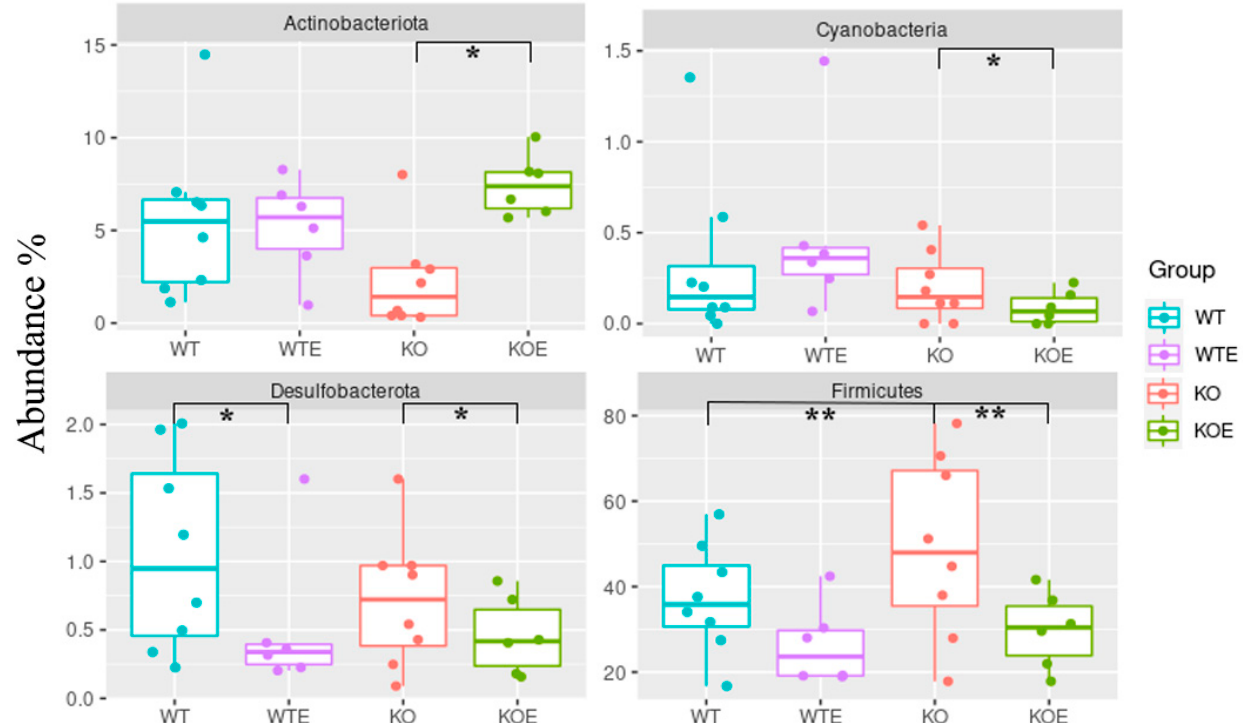
Figure 5. Influence of alcohol and genotype on mice in the four dominant phyla. The abundances of each phylum were assessed for significant differences in WTE vs. WT, KOE vs. KO, and KO vs. WT. A differential expression analysis was determined using the DESeq2 package and is shown in Table 1. Library normalization was performed using the poscounts method and local fitting for the negative binomial distribution model. The Benjamini–Hochberg method was applied to perform p -value correction. * p < 0.05, ** p < 0.01. Table 1. Differential expression in the bacteria phylum in WTE vs. WT, KOE vs. KO, and KO vs. WT. Reads of each ASV were merged to their respective phylum level, and a differential expression was conducted using the DESeq2 package. Only the phyla with a raw p -value <0.05 are shown.